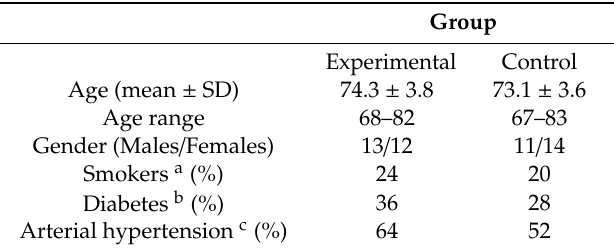
Table 1. Main characteristics of patients enrolled in the study, divided according to treatment group.